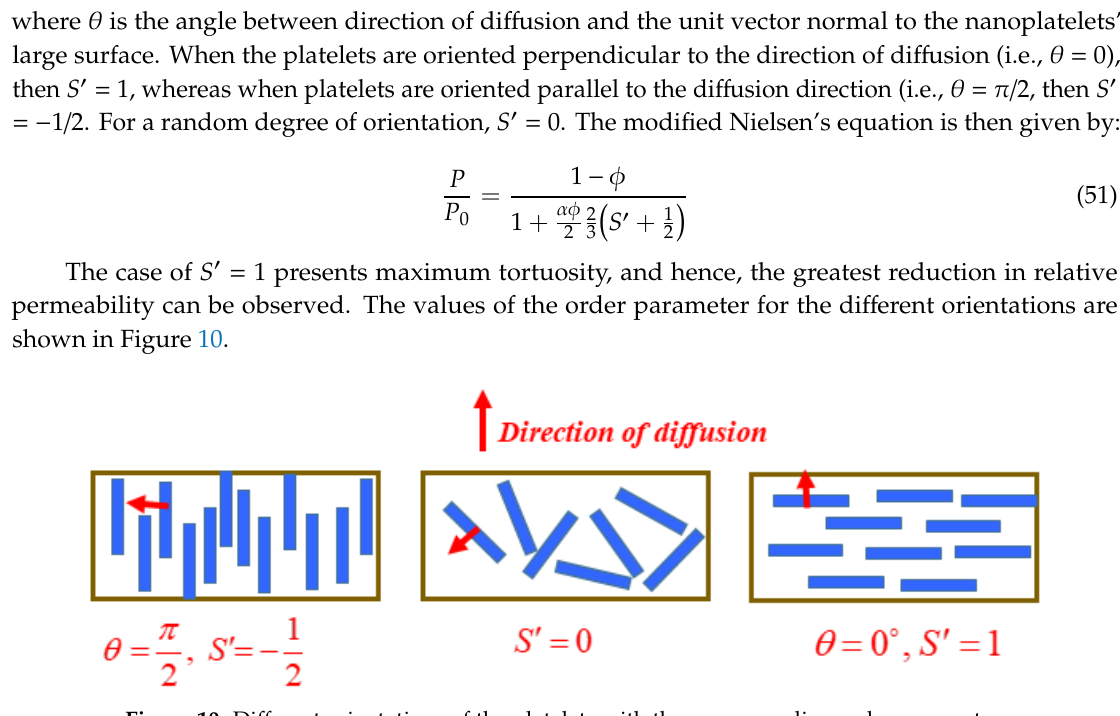
Figure 10. Di ff erent orientations of the platelets with the corresponding order Figure 10. Different orientations of the platelets with the corresponding order parameter.